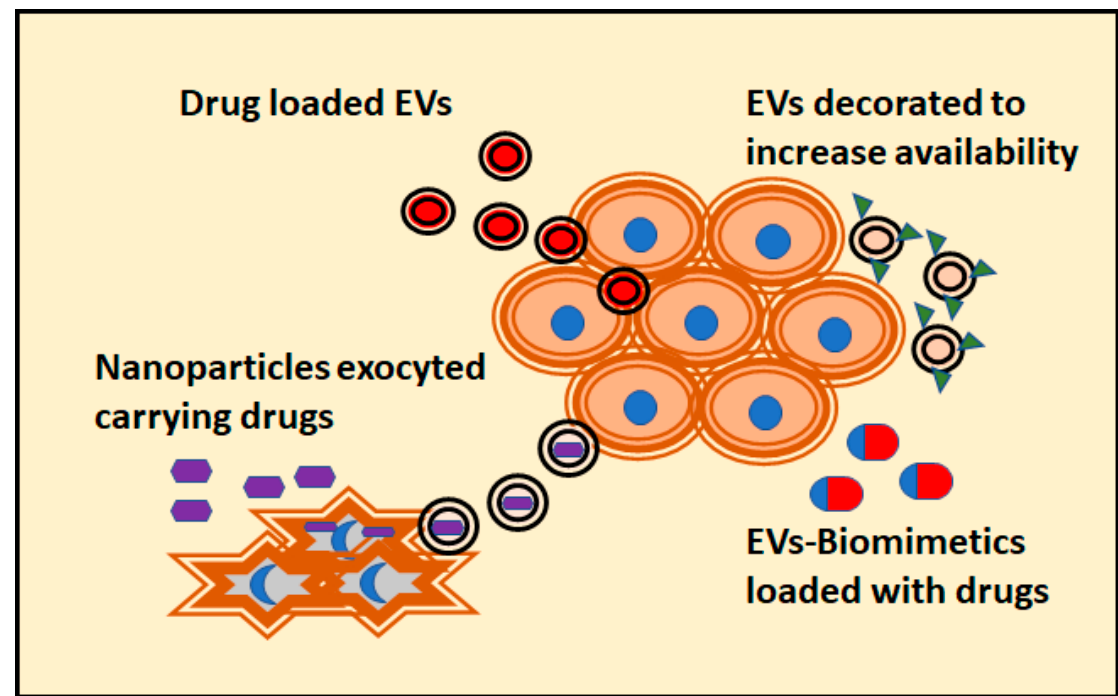
Figure 2. Different strategies attempted to confer antitumoral activity to EVs are depicted. The preferred 3D culture assay for these tests are organoids, with a closer physiological response to in vivo cells. In addition, the penetrance of the drug carried by EVs compared to its free forms can be evaluated. This measurement is not possible to obtain using 2D cultures.